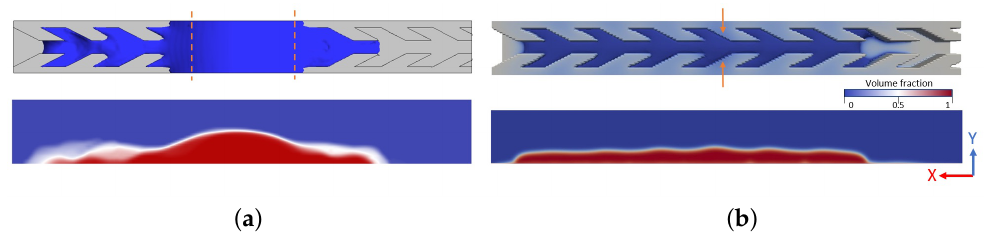
Figure 18. ( a ) Diffusion at the water/air interface in VOF simulation with compressive scheme. Parameters are as in Figure 11. ( b ) LBM simulation performs clear phase separation without excess diffusion at the interface with an equal number of cell elements. Red arrows indicate the location of the inlet. Contact angle θ =